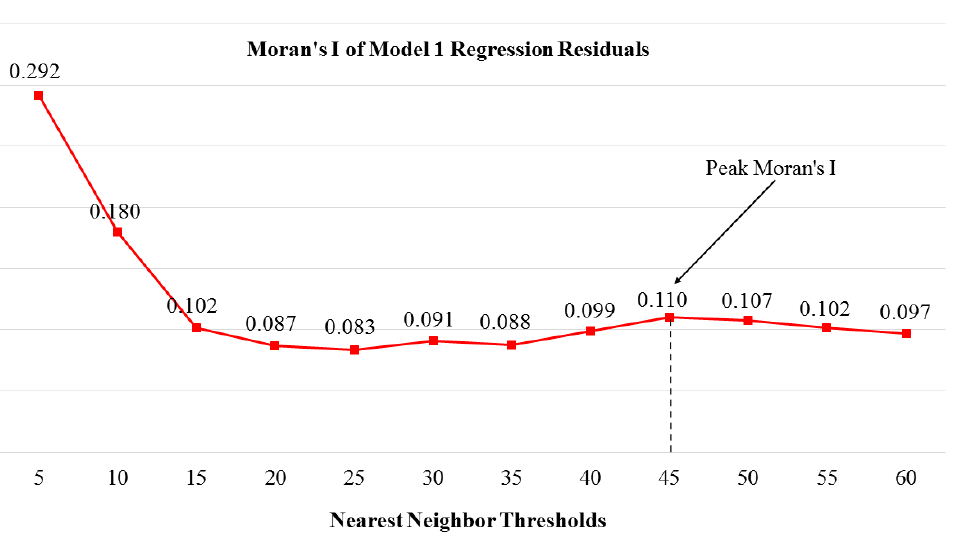
Figure 3. Results from the spatial autocorrelation analysis of the residuals from the logistic regression model without the organizational environment variable (see Model 1, Table 3). The peak Moran’s I value of 0.110 at the 45 nearest neighbor threshold motivated the use of the 45 nearest neighbor threshold for the organizational environment independent variable in the full regression model (Model 2, Table 3).